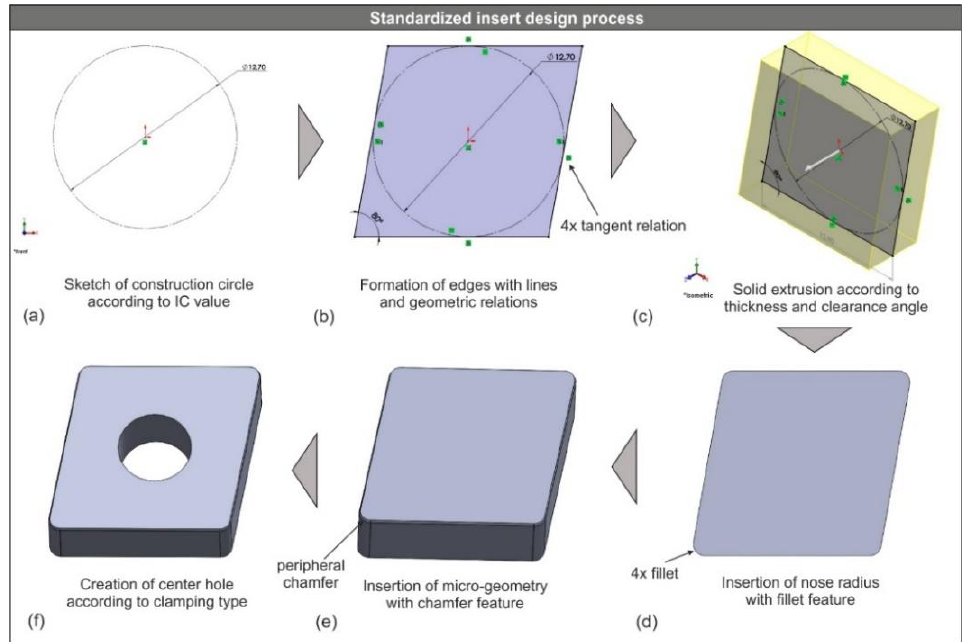
Figure 5. The design workflow for the CNGA-family inserts: ( a ) the construction circle, ( b ) the contour, ( c ) the extrusion, ( d ) the corner radius, ( e ) the micro-geometry and ( f ) the clamping hole.